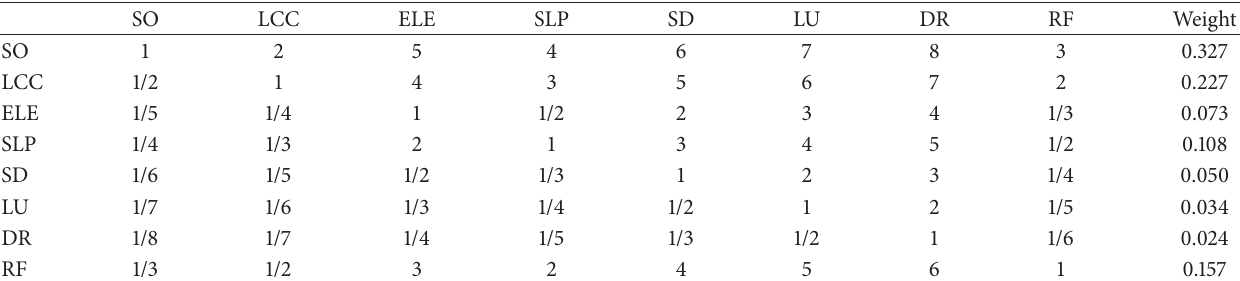
Table 3: A pairwise comparison matrix for assessing the weight (relative importance) of criteria for land suitability for agriculture in Tuban